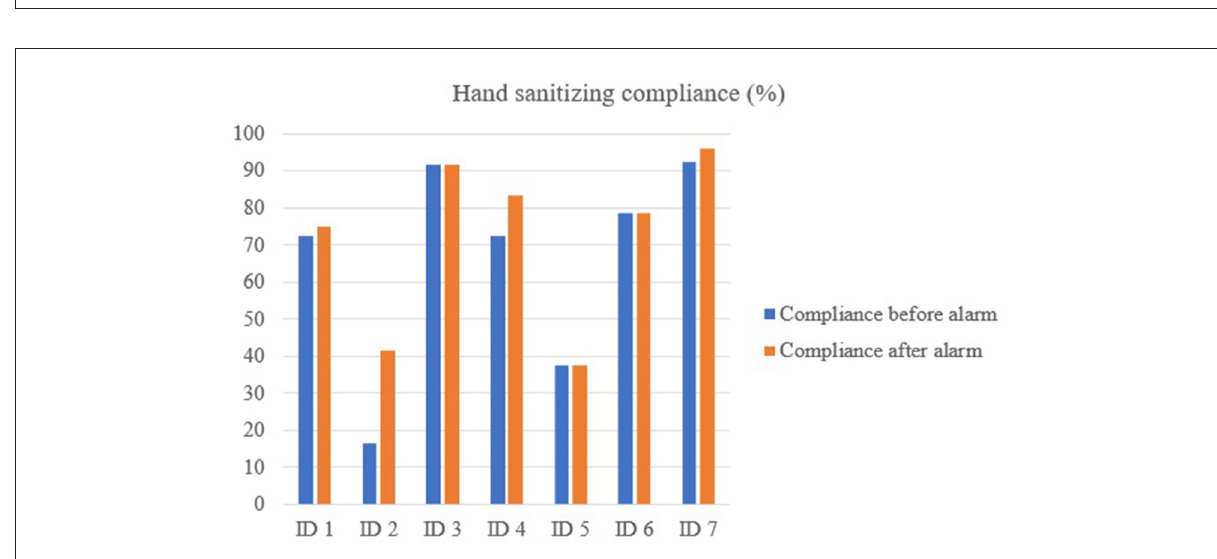
FIGURE3 Hand sanitizing compliance rate at the individual level using the MediHandTrace system; before and after hearing the alarm.